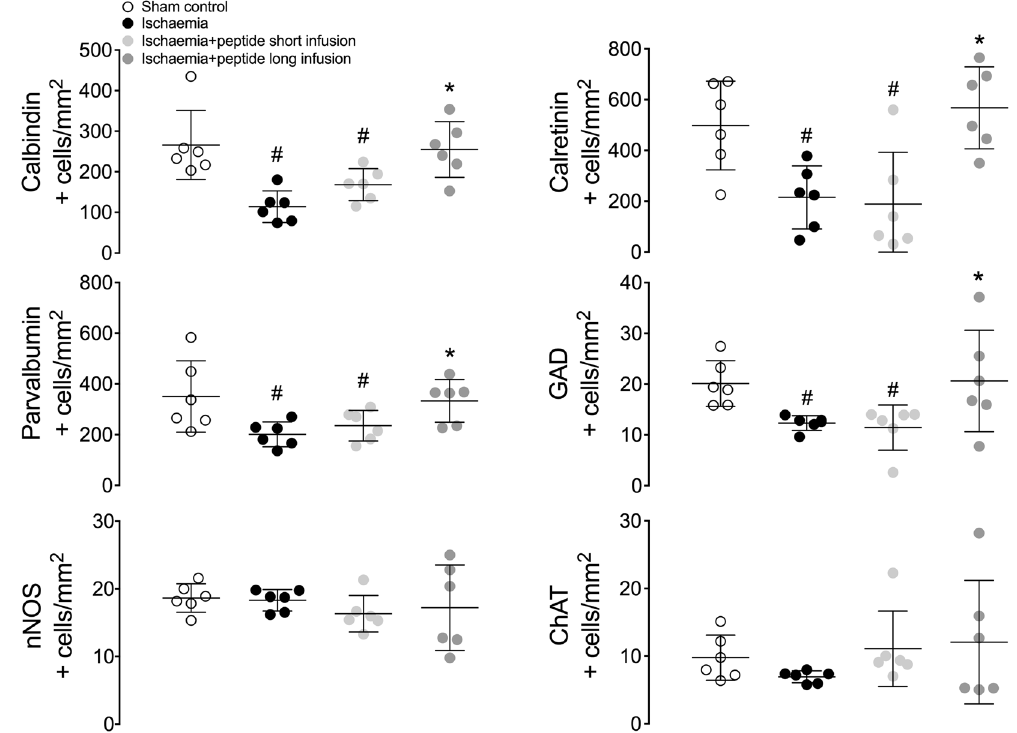
Figure 2. Phenotypic striatal neuronal density in the striatum (including the caudate nucleus and putamen). Data are mean ± SD from n = 6/group. # p < 0.05 vs. sham ischaemia; * P < 0.05 vs. ischaemia +